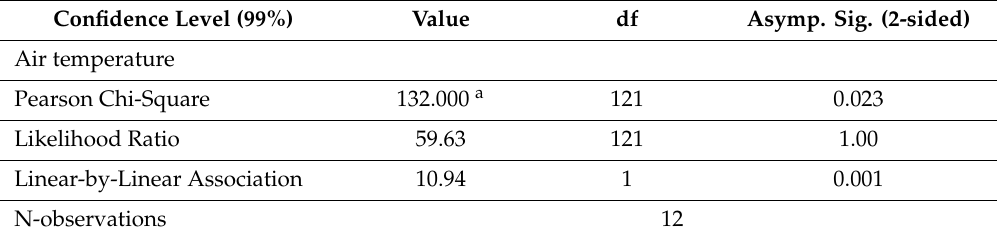
Table 8. Chi-square tests for the o ffi ces without passive strategy and o ffi ces with passive strategy. Confidence Level (99%) Value df Asymp. Sig. (2-sided) Air temperature Pearson Chi-Square 132.000 a 121 0.023 Likelihood Ratio 59.63 1.00 Linear-by-Linear Association